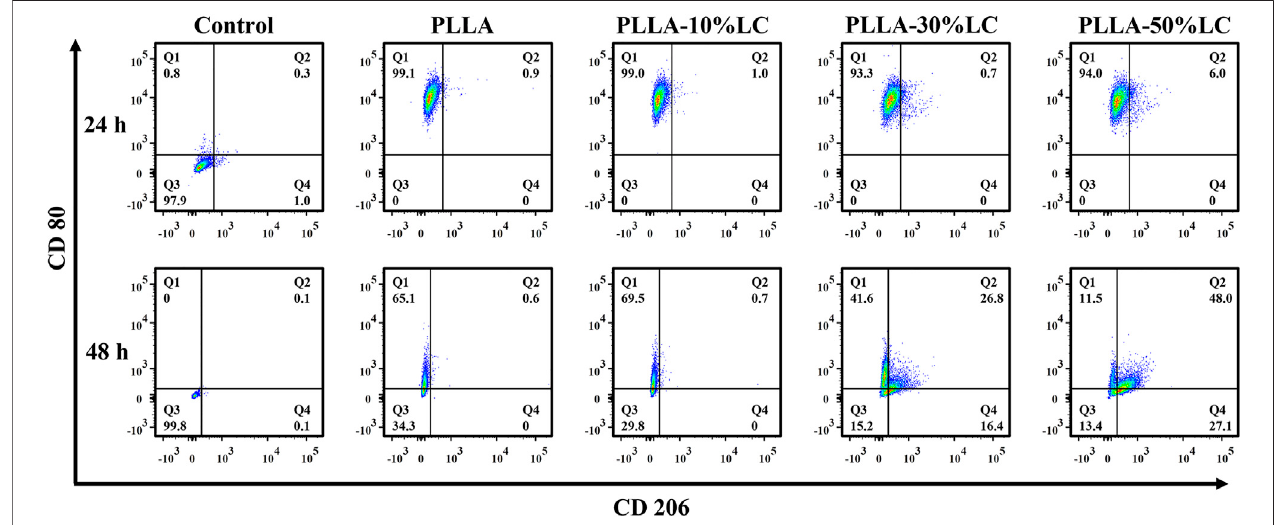
FIGURE 5 | Polarization of macrophages on the